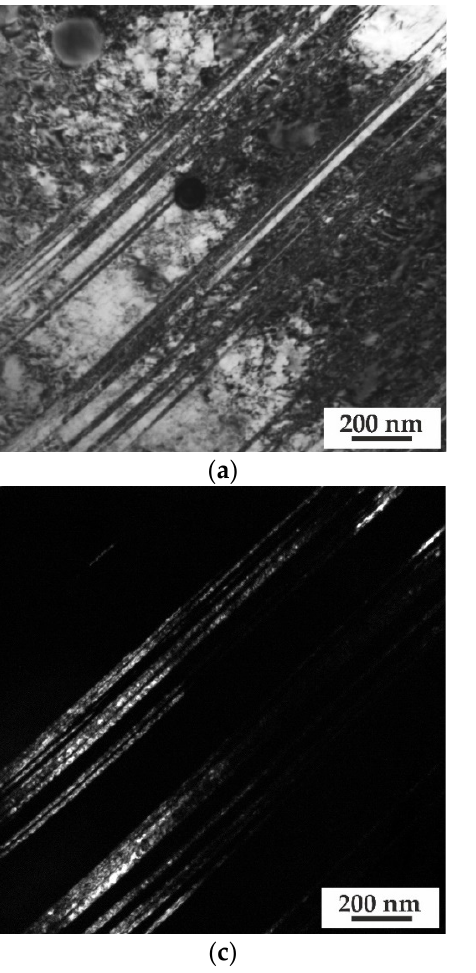
Figure 6. TEM images after CR. BF image ( a ), SAED pattern, zone axes close to [110] matrix + [ − 11 − 0] twins ( b ), Dark-field (DF) images in twin reflection ( c ) and matrix reflection ( d ).